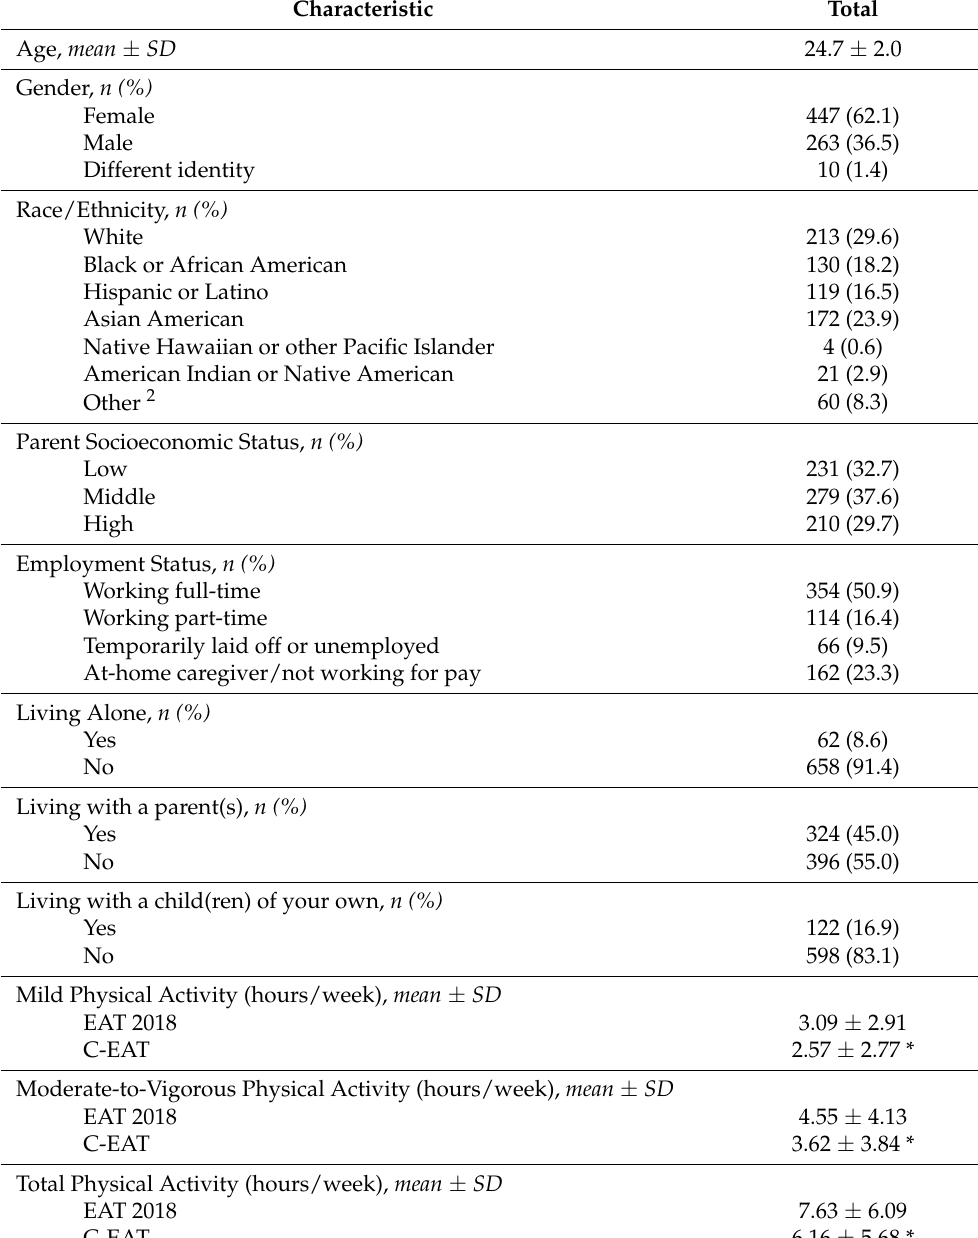
Table 1. Participant Demographics and PA behaviors reported on the C-EAT survey in